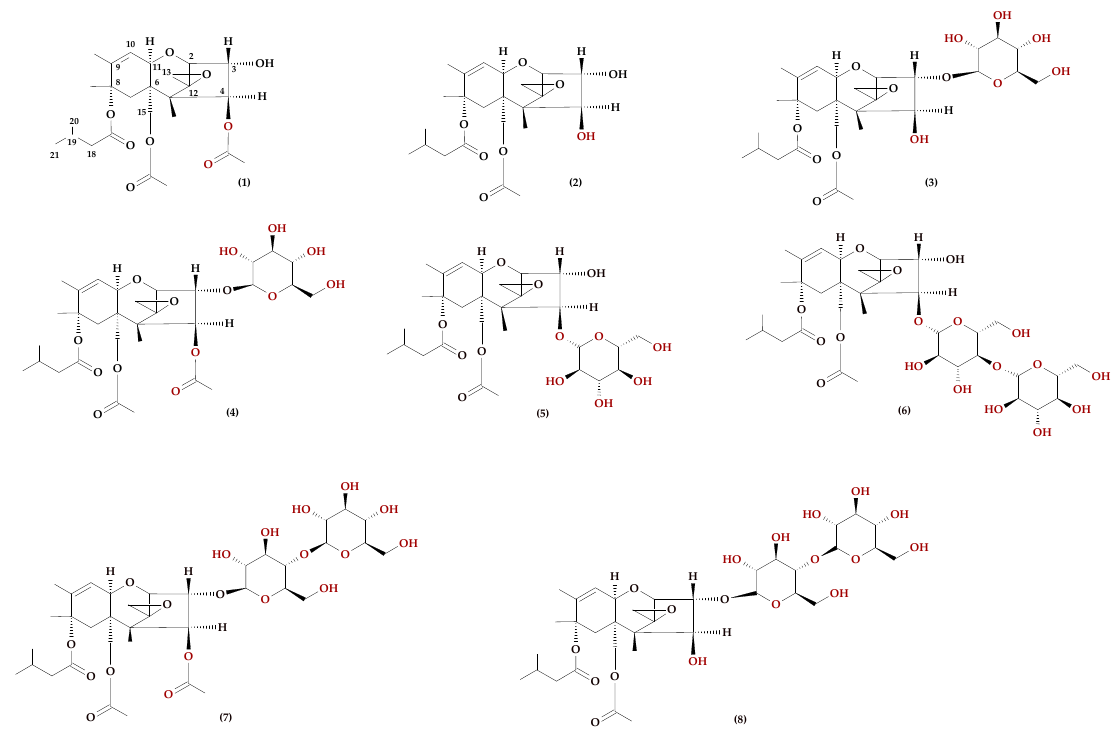
Figure 3. Chemical structure of some derivatives of HT ‐ 2 and T ‐ 2 toxins: ( 1 ) T ‐ 2 toxin, ( 2 ) HT ‐ 2 toxin, ( 3 ) HT ‐ 2 ‐ 3Glc, ( 4 ) T ‐ 2 ‐ 3Glc, ( 5 ) HT ‐ 2 ‐ 4Glc, ( 6 ) HT ‐ 2 ‐ 4diGlc, ( 7 ) T ‐ 2 ‐ 3diGlc, ( 8 ) HT ‐ 2 ‐ 3diGlc.